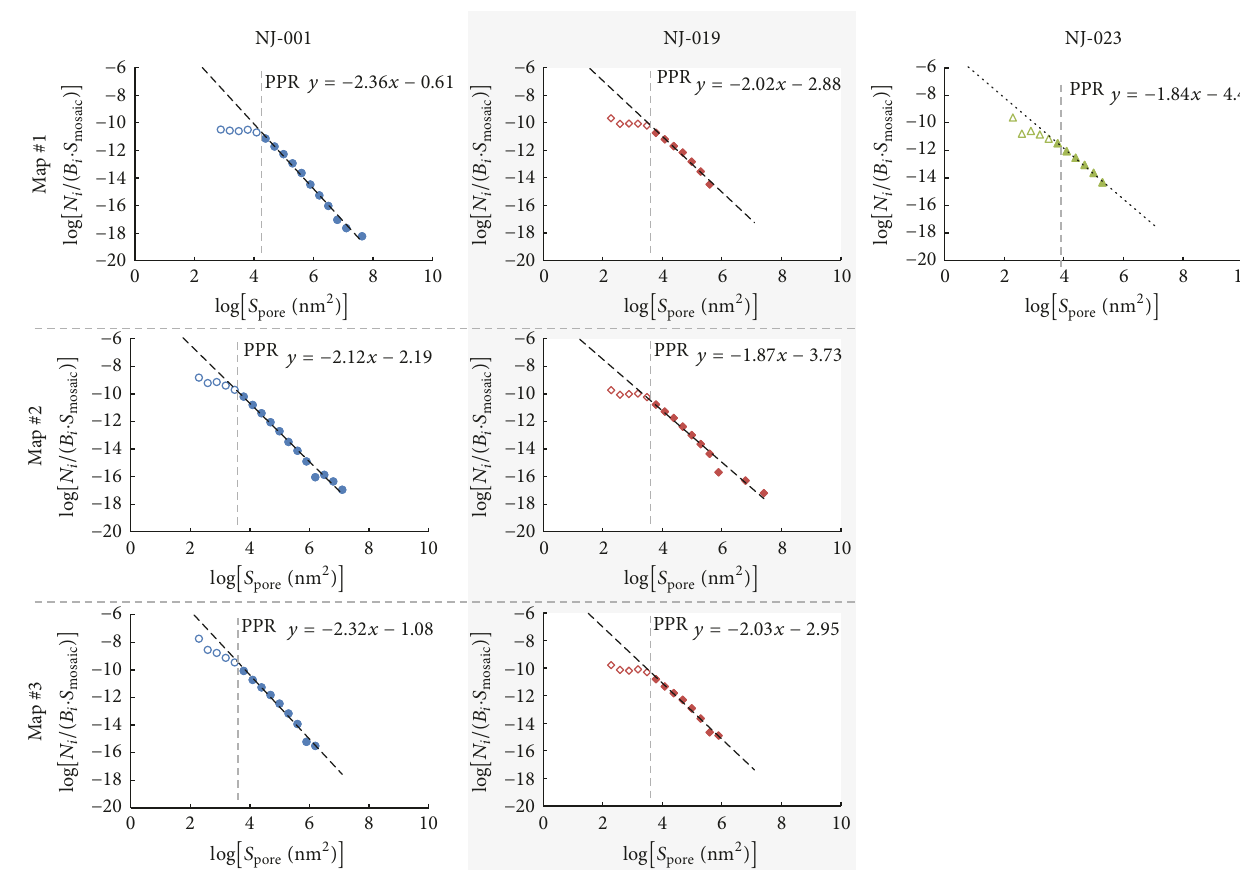
Figure 11: Log-log pore size distributions for all three